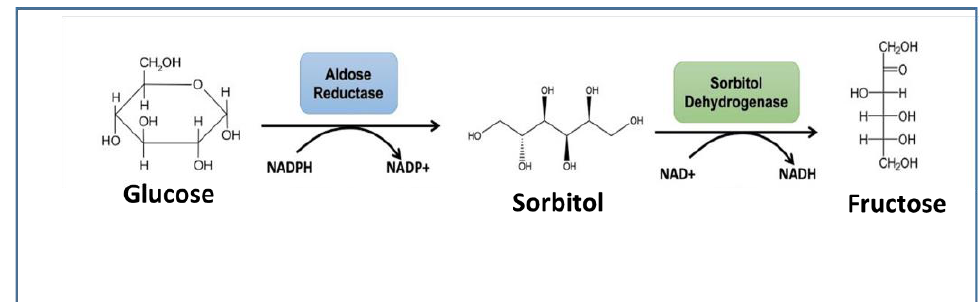
Figure 1. Polyol metabolic